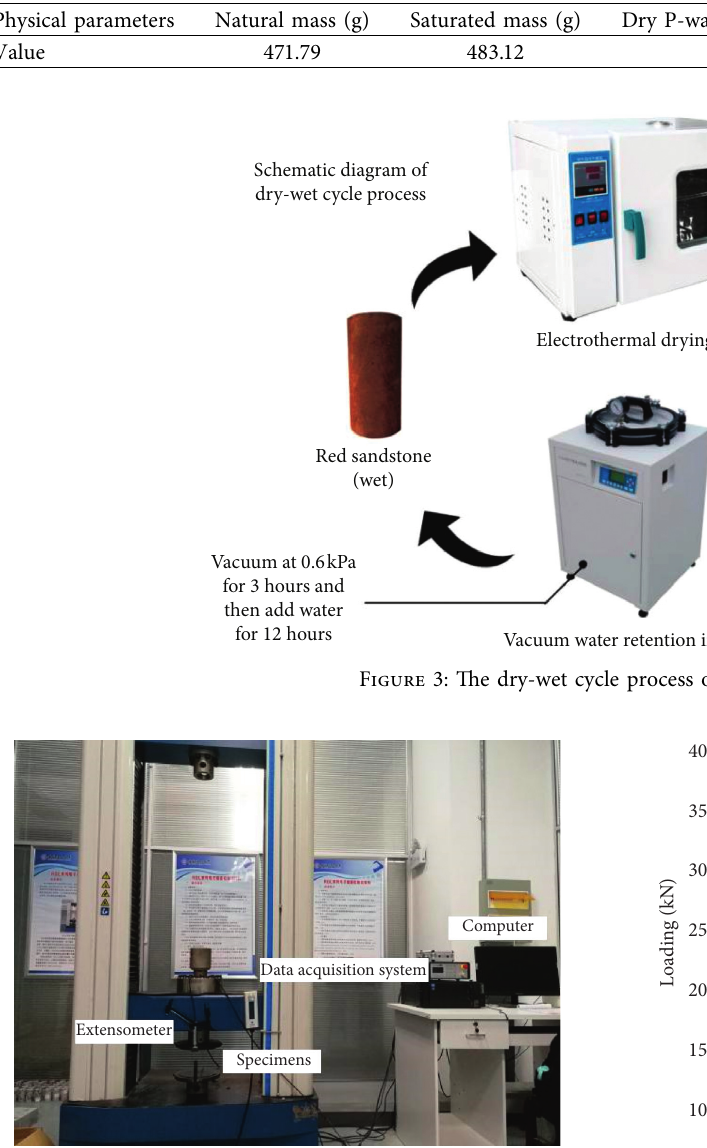
Figure 4: The RDL-200 electronic creep relaxation test machine.